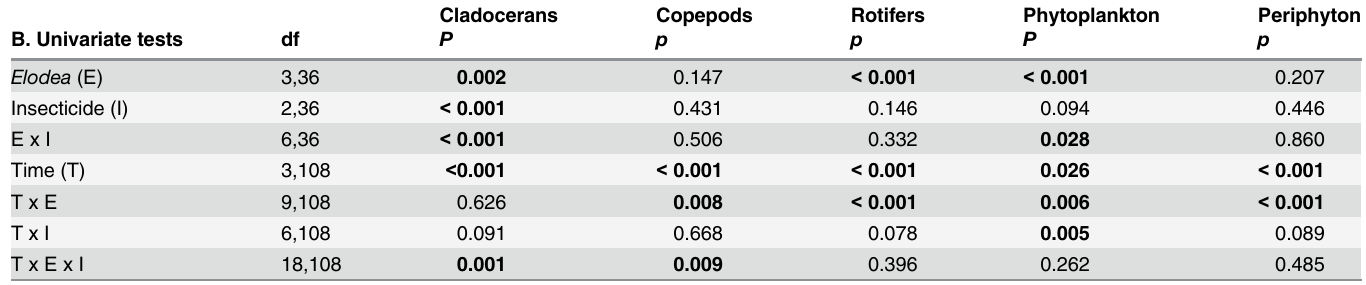
Table 2. Results of univariate ANOVAs examining the effects of time, macrophyte treatment, malathion treatment, and their interactions on each biotic response